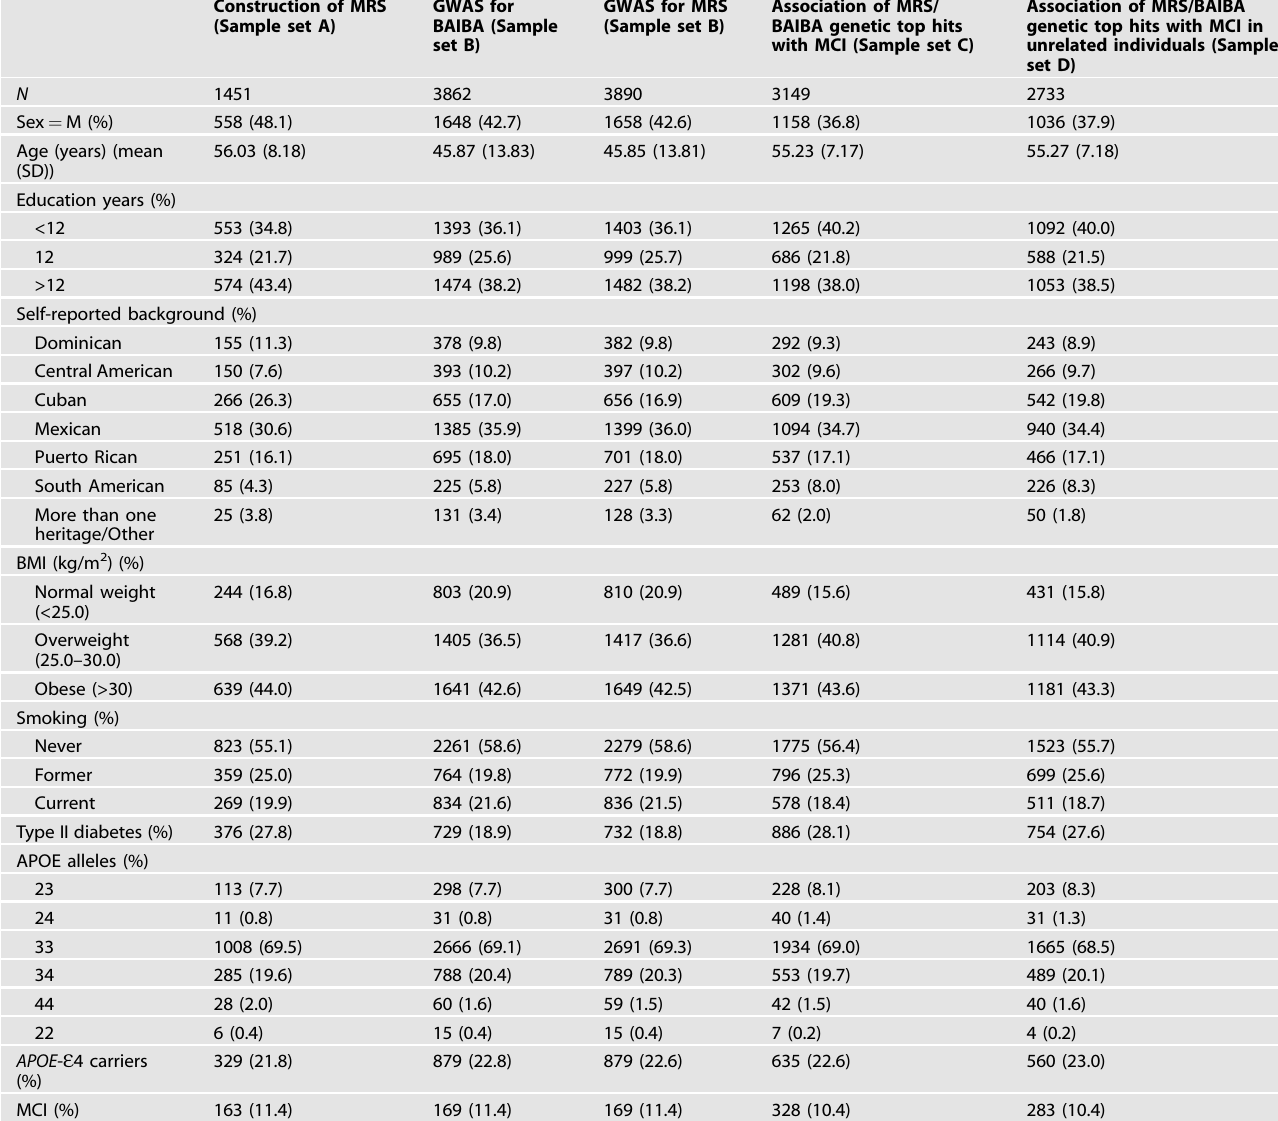
Table 1. Demographics, health, and lifestyle characteristics of the HCHS/SOL study population datasets. Construction of MRS (Sample set